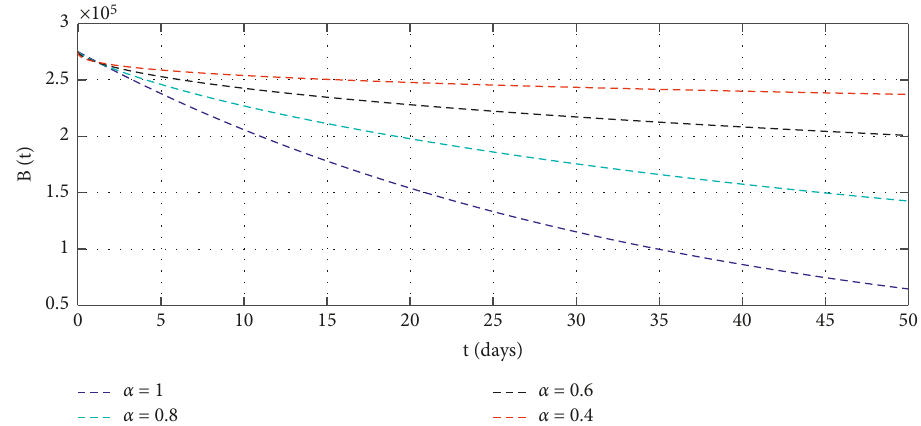
Figure 2: Simulations of V. cholerae dynamics with different memory effect.